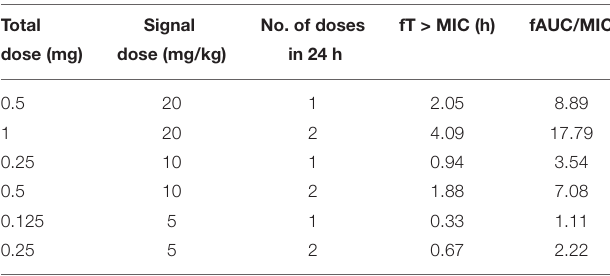
TABLE 1 | Treatment regimens and resulting PK/PD parameters for S. aureus E48 in the mouse peritonitis study. Total